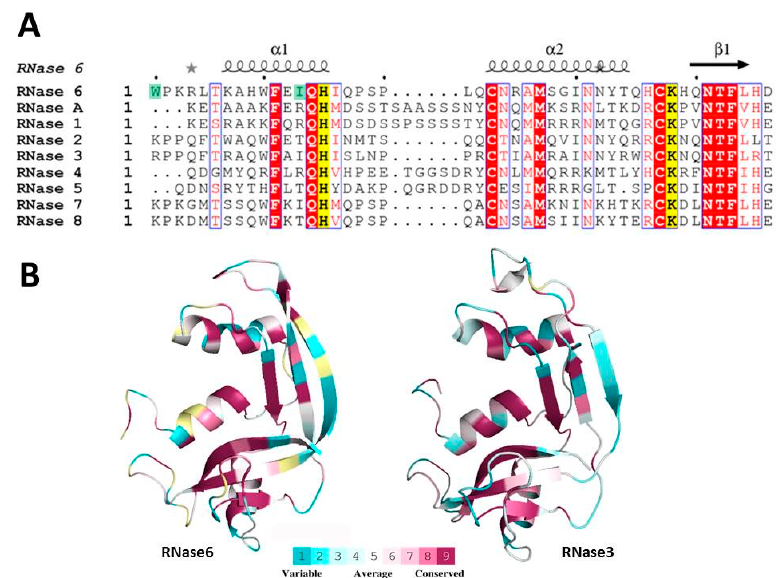
Figure 1. ( A ) Structure-based sequence of the eight canonical human RNases N-terminal domain together with RNaseA. The active site residues are highlighted in yellow. RNase6 tested mutations related to antimicrobial activity are labeled in green. The alignment was performed using ClustalW , and the picture was drawn using ESPript [33]. Labels are as follows: red box, white character for strict identity; red character for similarity in a group and character with blue frame for similarity across groups (red box, white character: strict identity; red character: similarity in a group; red character with blue frame: similarity across groups; yellow box, black character: catalyst residue); ( B ) RNase6 (PDB 4X09; [34]) and RNase3 (PDB 4A2O; [35]) three-dimensional structure surface representations using the CONSURF web server ([36]) featuring the relationships among the evolutionary conservation of amino acid positions in the RNaseA family. The three-dimensional structure shows residues colored by their conservation score using the color-coding bar at the image